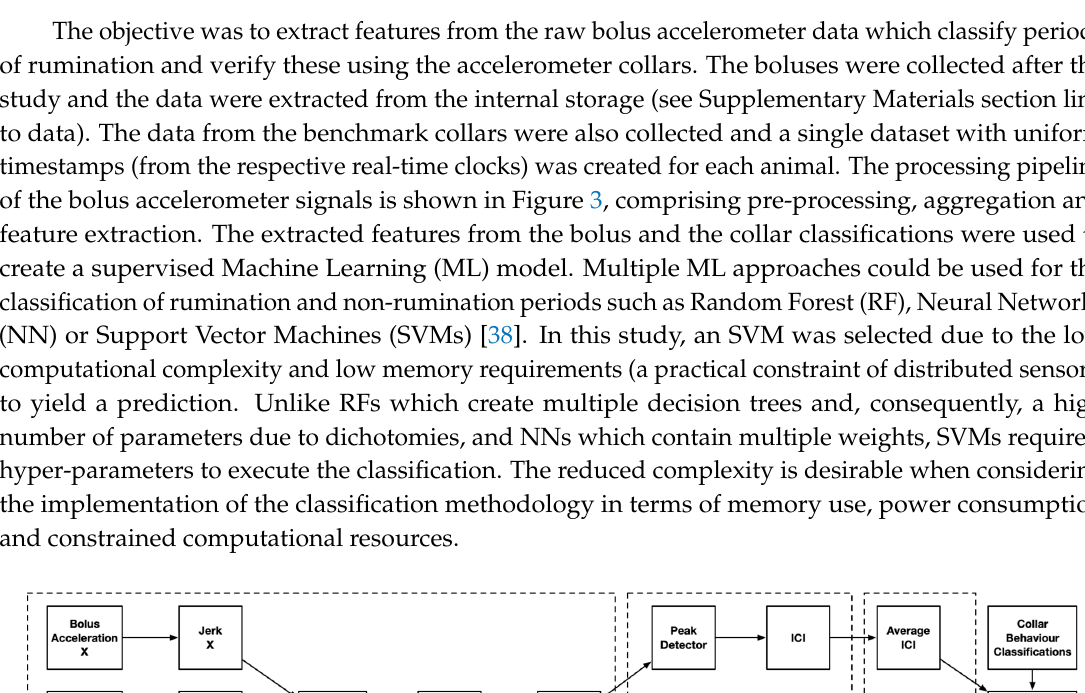
Figure 2. The layout of the bolus sensors used to monitor motion in the reticulum.